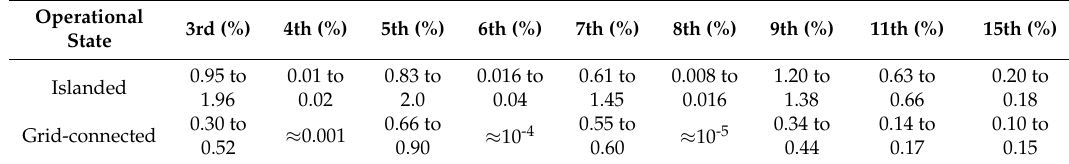
Table 2. Total average value for each measured voltage harmonic for all three phases.